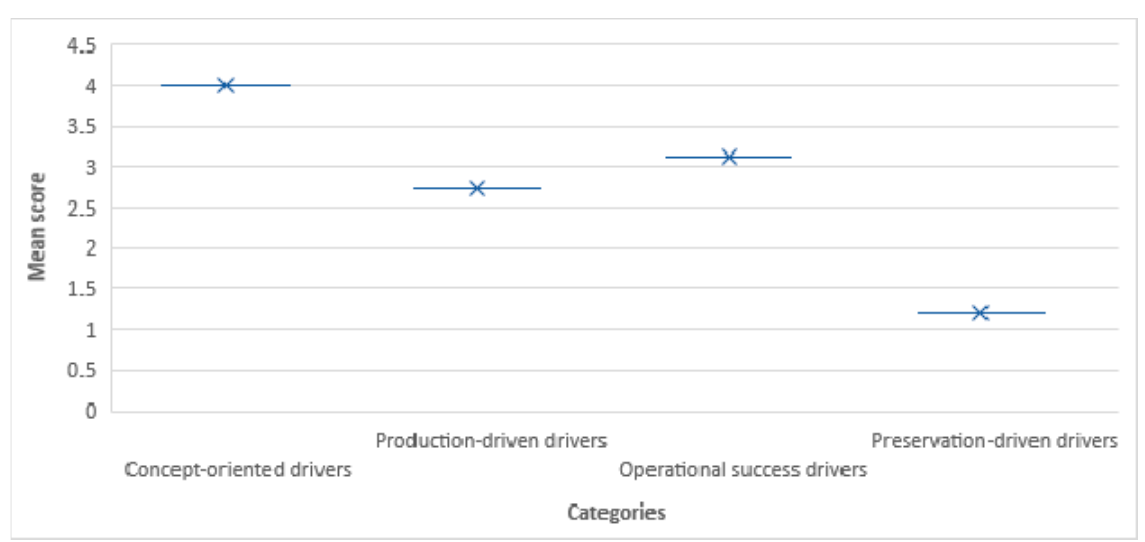
Figure 3. A conceptual framework for classification of the main drivers for DT adoption in construction industry. Table 4. Typology of Drivers for DT adoption in CI ranking.